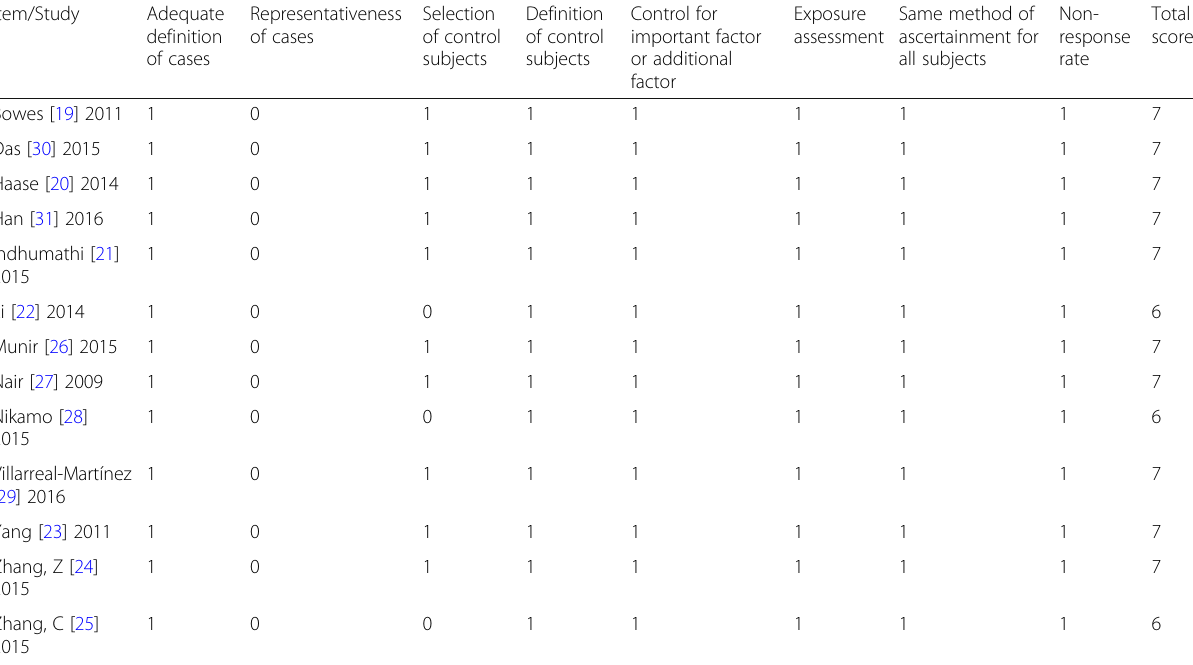
Table 3 Quality assessment of included studies according to the Newcastle-Ottawa